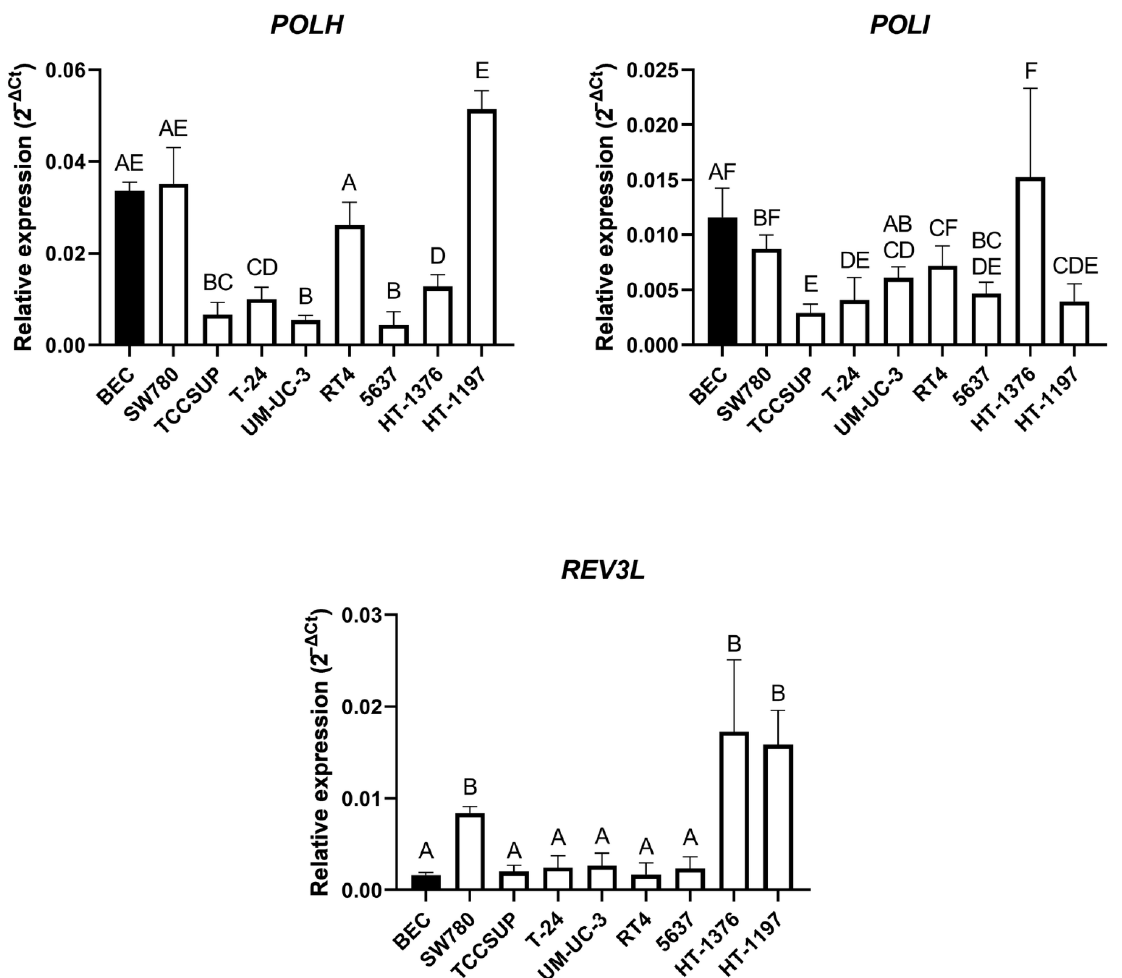
Figure 6. Relative basal expression of the selected TLS factors in the UCC lines and BEC. Relative mRNA expression of POLH ( upper panel left ), POLI ( upper panel right ) and REV3L ( lower panel ). Values are reported as the average with a 95% confidence interval from three biological and three technical replicates. Columns marked with the same letters did not show a statistically significant difference, while columns marked with different letters indicated a statistically significant difference using one-way ANOVA with Tukey post-hoc test for multiple comparison.